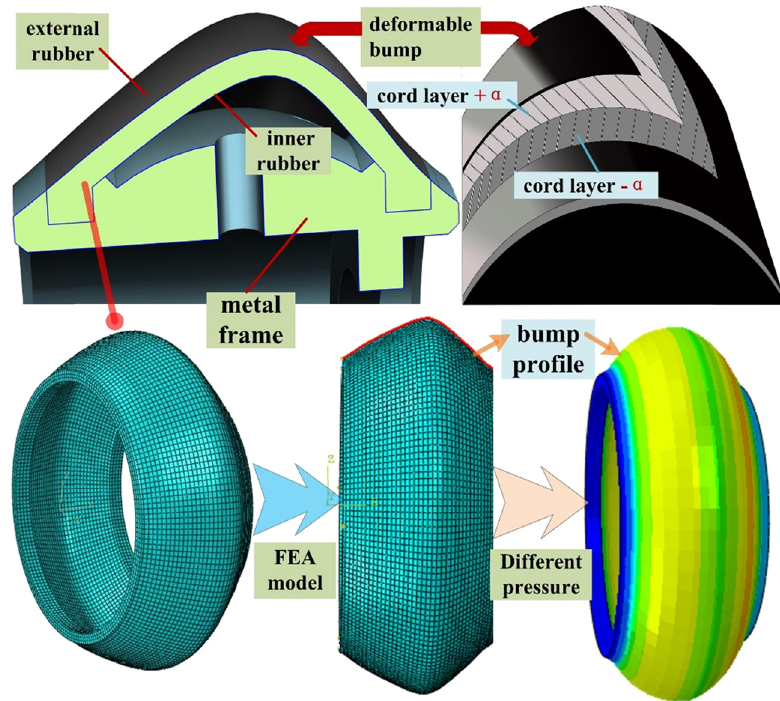
Figure 9: FEA model of